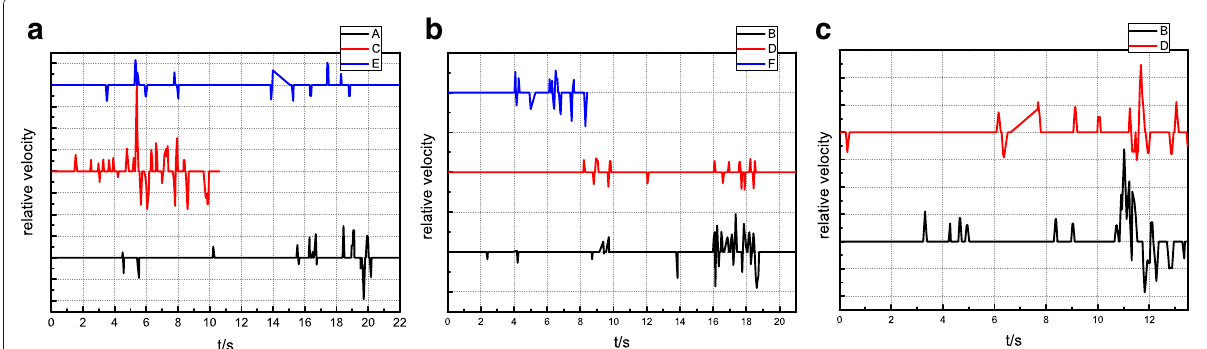
near the tags (unstable tags), and tags that were moved (mobile